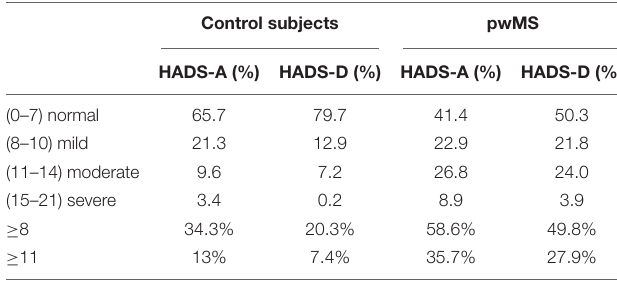
TABLE 2 | Score classification percentages of HADS anxiety and depression subscales for pwMS and control subjects. Control